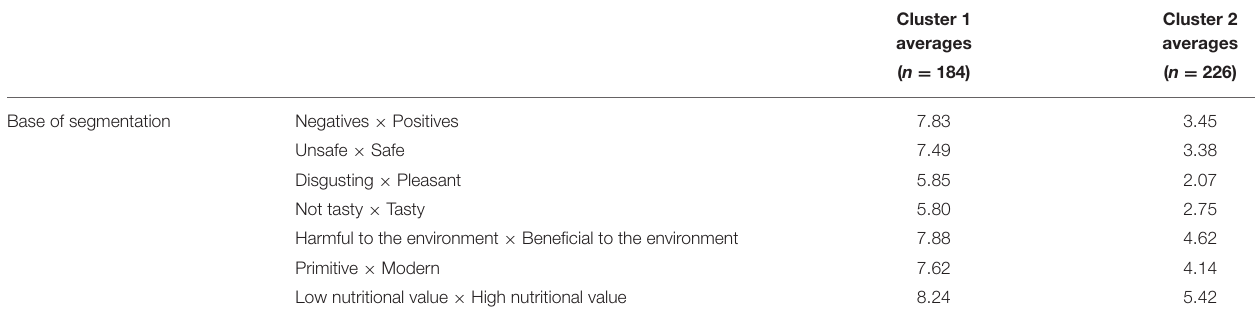
TABLE 6 | Segmentation according to the attitude toward insect-based products.